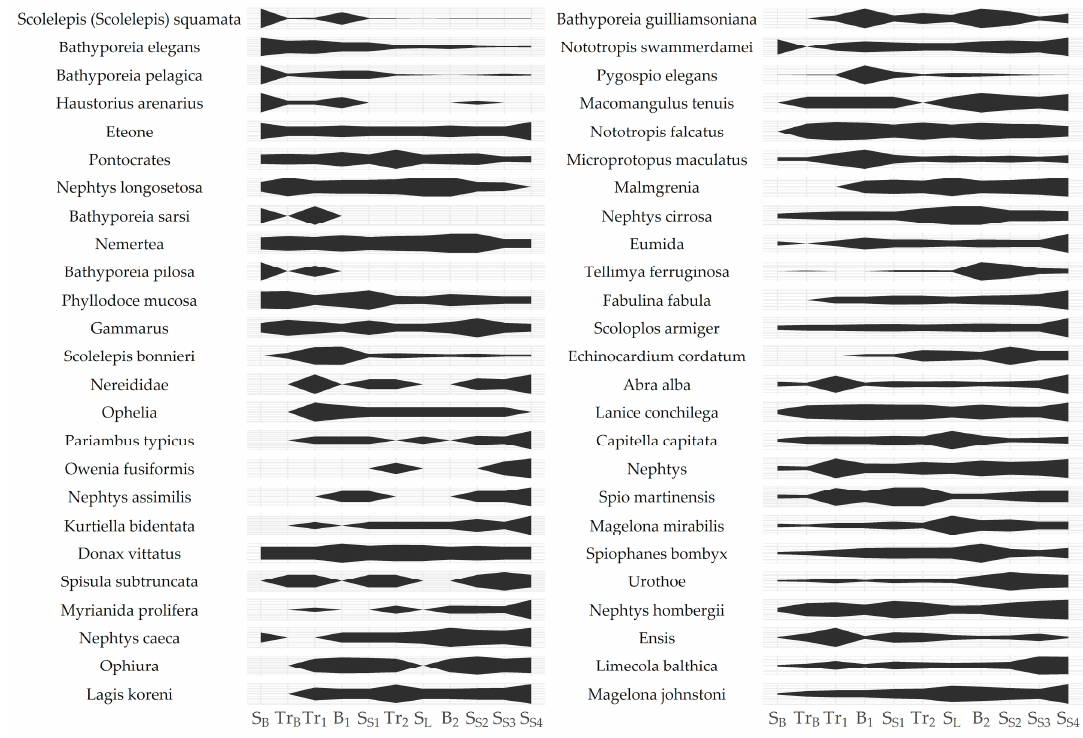
Figure 5. Kite diagram of the mean abundance for each species for the morphological features defined over the cross-shore profile. Starting at the left with the beach slope (S B ) to the deepest morphological feature three kilometers offshore (S S4 ). Species are arranged according to their score on the first pRDA axis based on species abundance and corrected for the effect of year and alongshore variance.